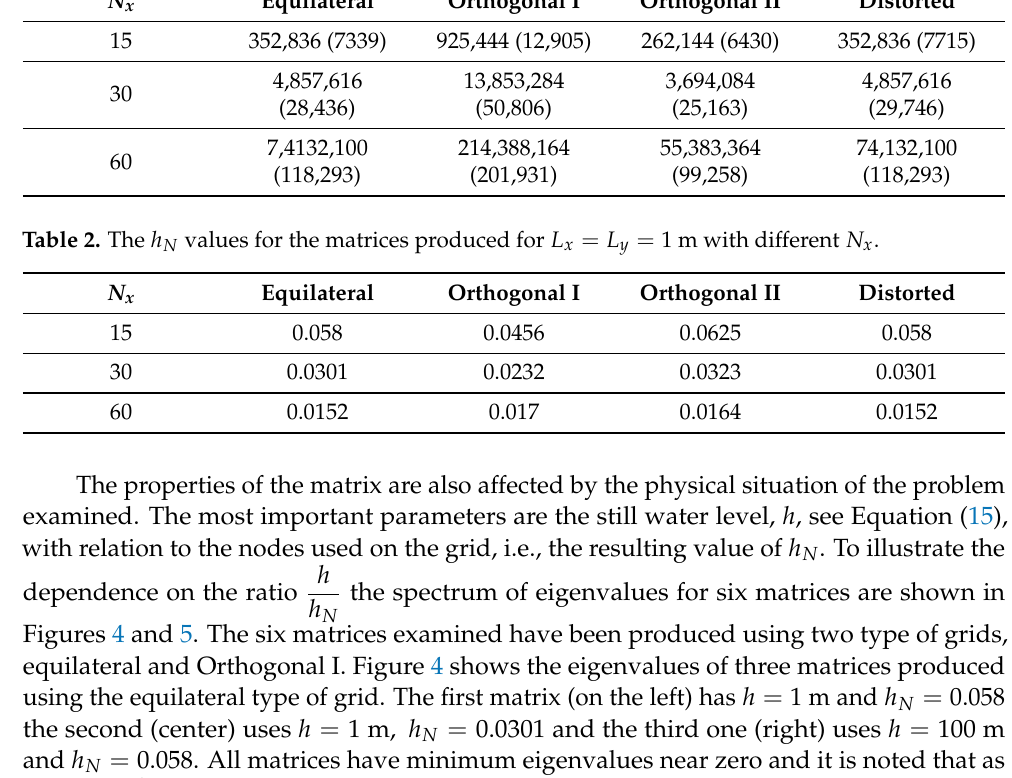
Table 1. Total (2 N × 2 N ) and non-zero elements ( N z ) for the matrices produced for L x = Ly = 1 m with different N x . N x